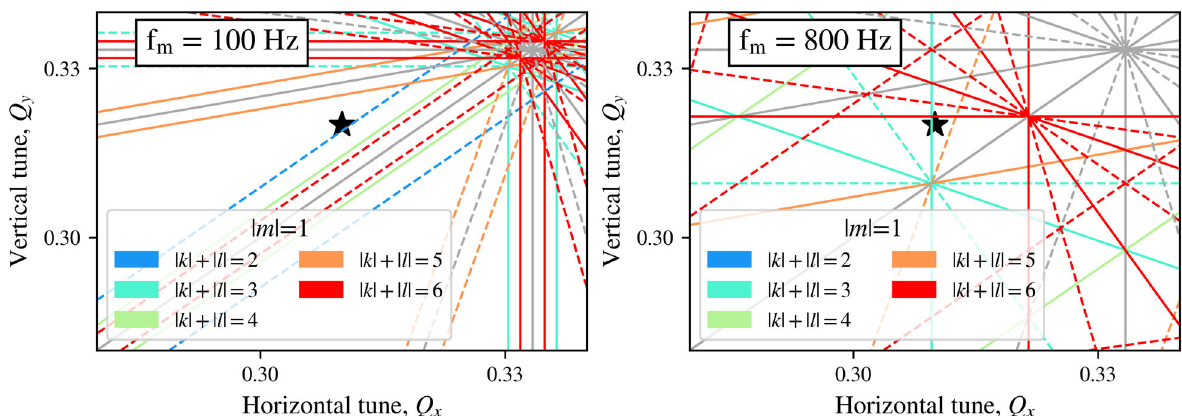
FIG. 2. An illustration of Eq. (11) for the nominal resonances (gray) and the first sideband ( m ¼ 1 ) of the linear coupling resonance ( N ¼ j k j þ j l j ¼ 2 , blue), the third ( N ¼ 3 , cyan), fourth ( N ¼ 4 , green), fifth ( N ¼ 5 , orange), and sixth ( N ¼ 6 , red) order resonance for a tune modulation at 100 Hz (left) and 800 Hz (right). The working point is also illustrated (black). The solid and dashed lines illustrate the normal (even value of l ) and skew (odd value of l ) resonances,